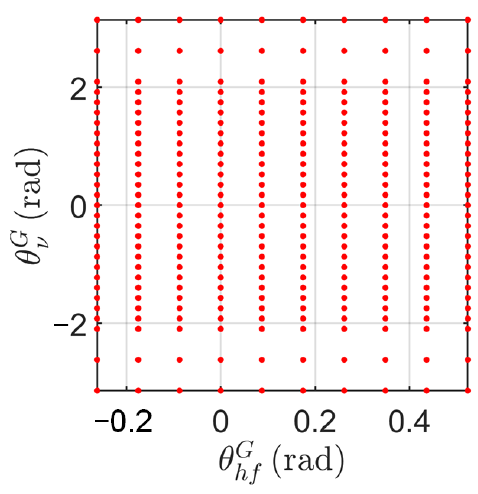
Figure 6. Simulation cases of static tests.